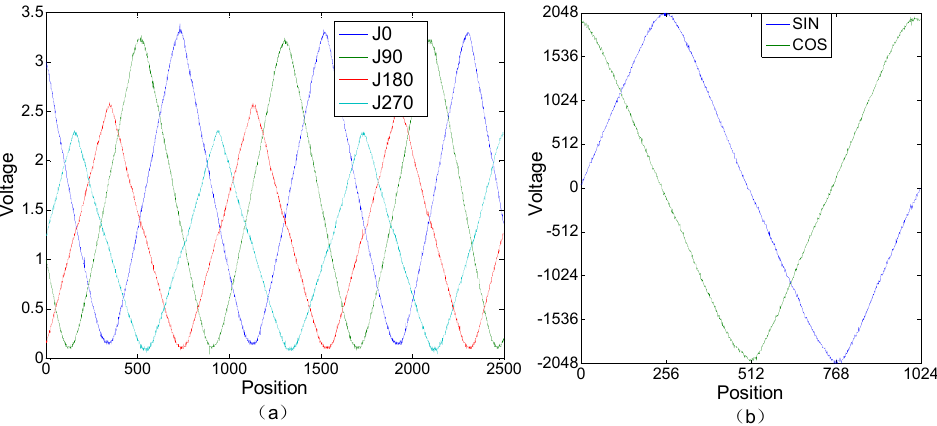
Figure 5. Encoder Moiré fringe original signals: ( a )the four-way original Moiré fringe signals; ( b )the normalized sinusoidal (SIN) and cosine (COS) signals.